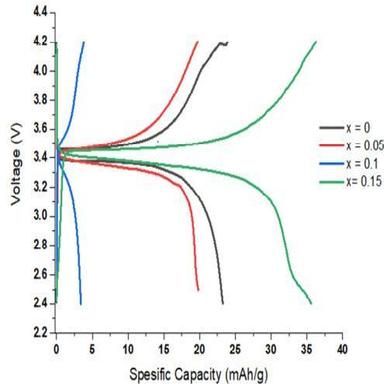
CD curves for LiFeSixP1-xO4/C with x = 0; 0.05; 0.10; and 0.15